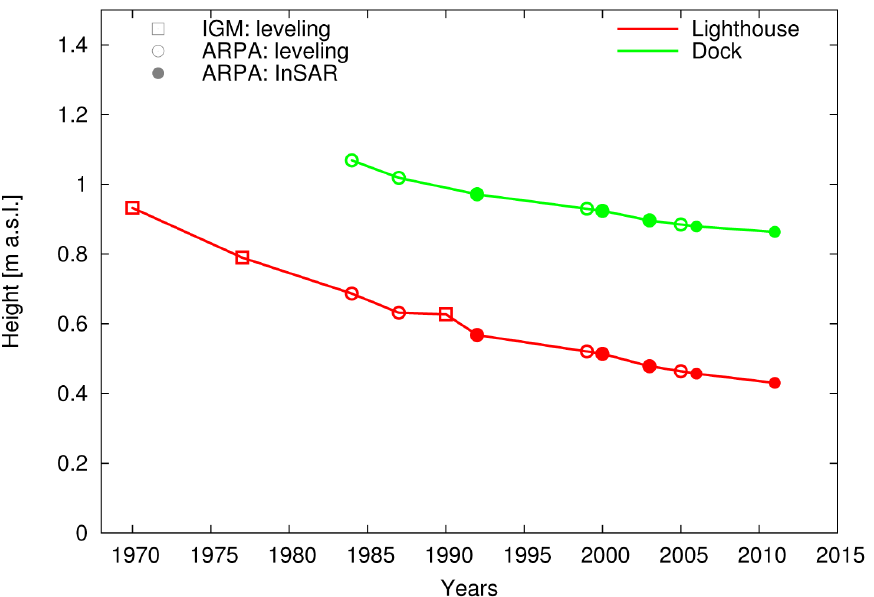
Figure 6. Elevation measurements at the Porto Corsini lighthouse (red) and dock (green) benchmarks at various epochs. The various data sources and sampling methods are denoted by different symbols, as indicated in the legend (see Tables 1 and 2 for